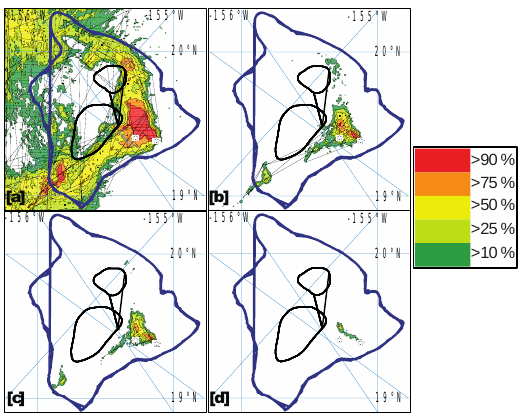
Figure 1: Probability of exceedance (PE) maps for SO 4 levels at [a] 1E-8 μg/m 3 , [b] 15 μg/m 3 , [c] 35 μg/m 3 , [d] 65 μg/m 3 , [e] 150 μg/m 3 , and [f] 250 μg/m 3 valid for period 1600-1700 HST 21 November 2013. Thresholds conform to Airnow.gov’s Air Quality Index for PM2.5 (sulfate) exposure. The stars denote the source locations, volcanic vents. The heavy black lines represent the 2,200 m height contour.